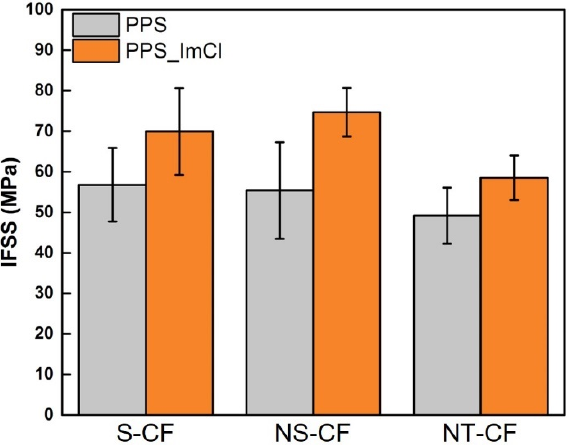
( b ) Figure 8. PPS ( a ) and PPS_ImCl ( b ) post-mortem droplets.